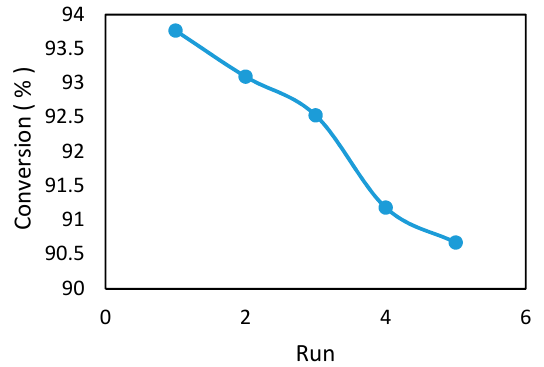
Figure 8. Effect of reusability of catalyst on biodiesel conversion at optimum conditions.